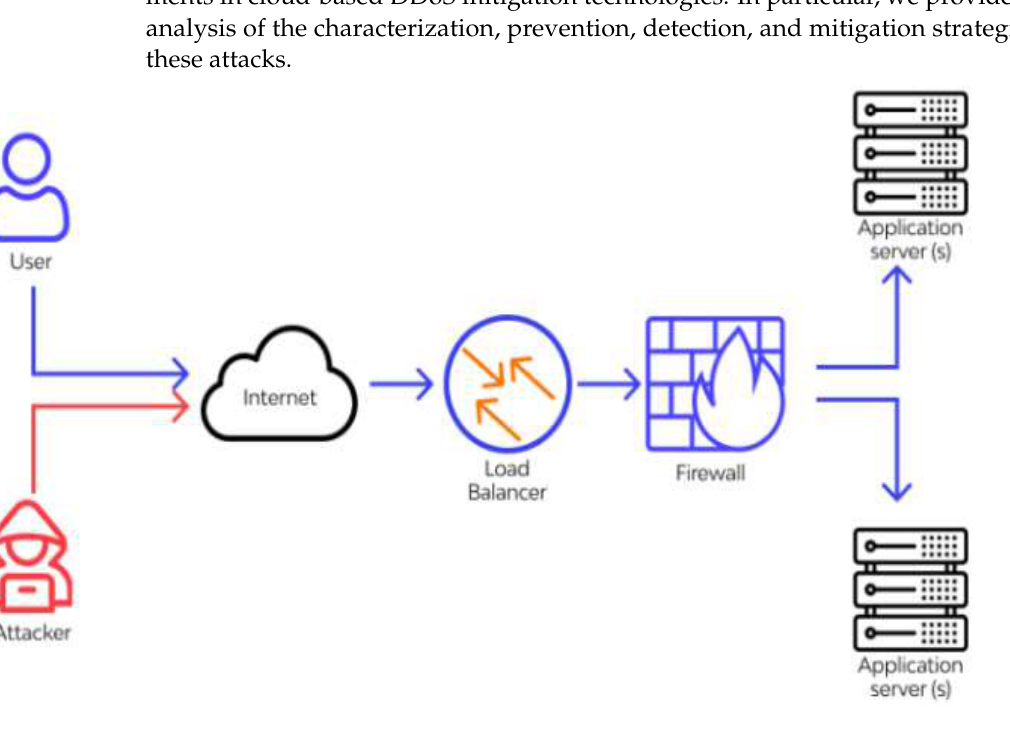
Figure 3. Attack by